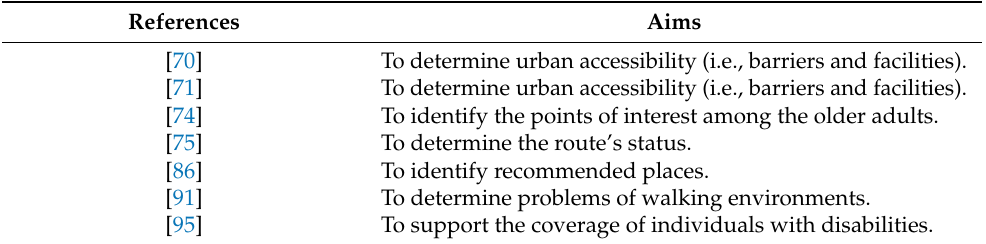
Table 6. Articles reporting